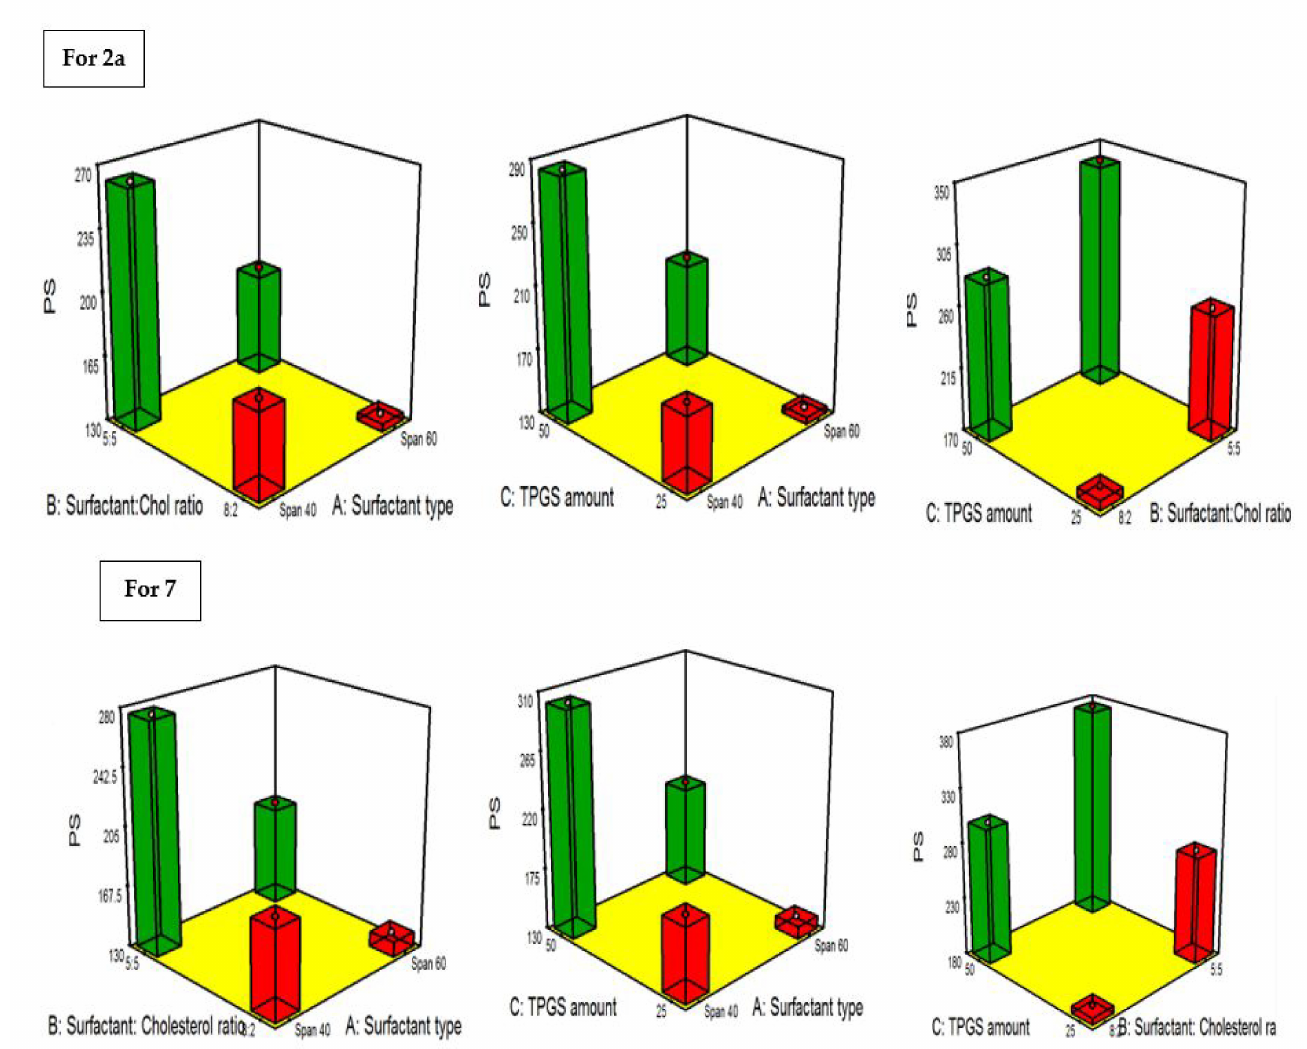
Figure 15. Three-dimensional surface response plots exploit the impact of ( A ) surfactant type, ( B ) surfactant:cholesterol ratio and ( C ) TPGS amount on PS of 2a and 7 -loaded TPGS-coated niosomes. Three-dimensional surface response plots exploit the impact of ( A ) bile salt type, ( B ) bile salt